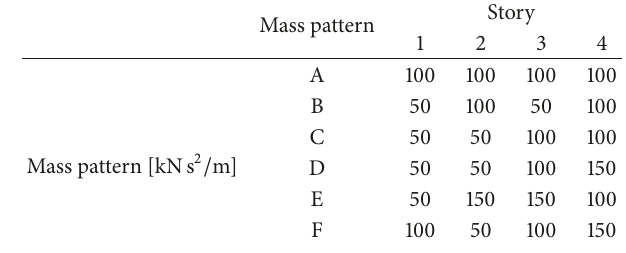
Table 11: Mass patterns used for the comparison of the damage errors reported in Figure 12.